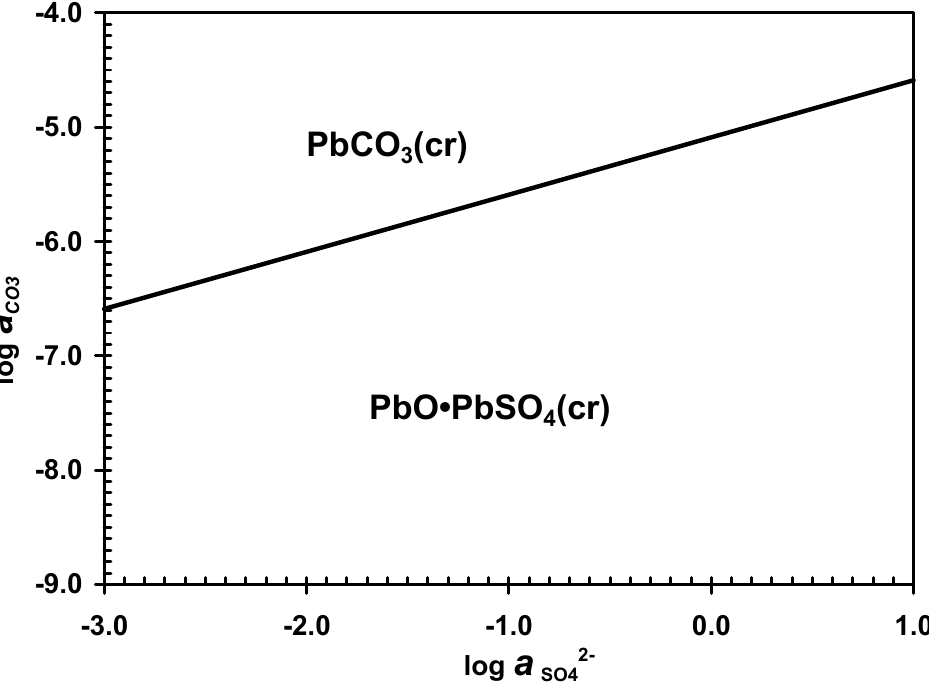
Figure 12. The stability fields of lead carbonate [PbCO 3 (cr)] and lead sulfate [PbSO 4 (cr)] at 25 °C in the space of log a versus log a in carbonate solutions for desulphurization of lead pastes.